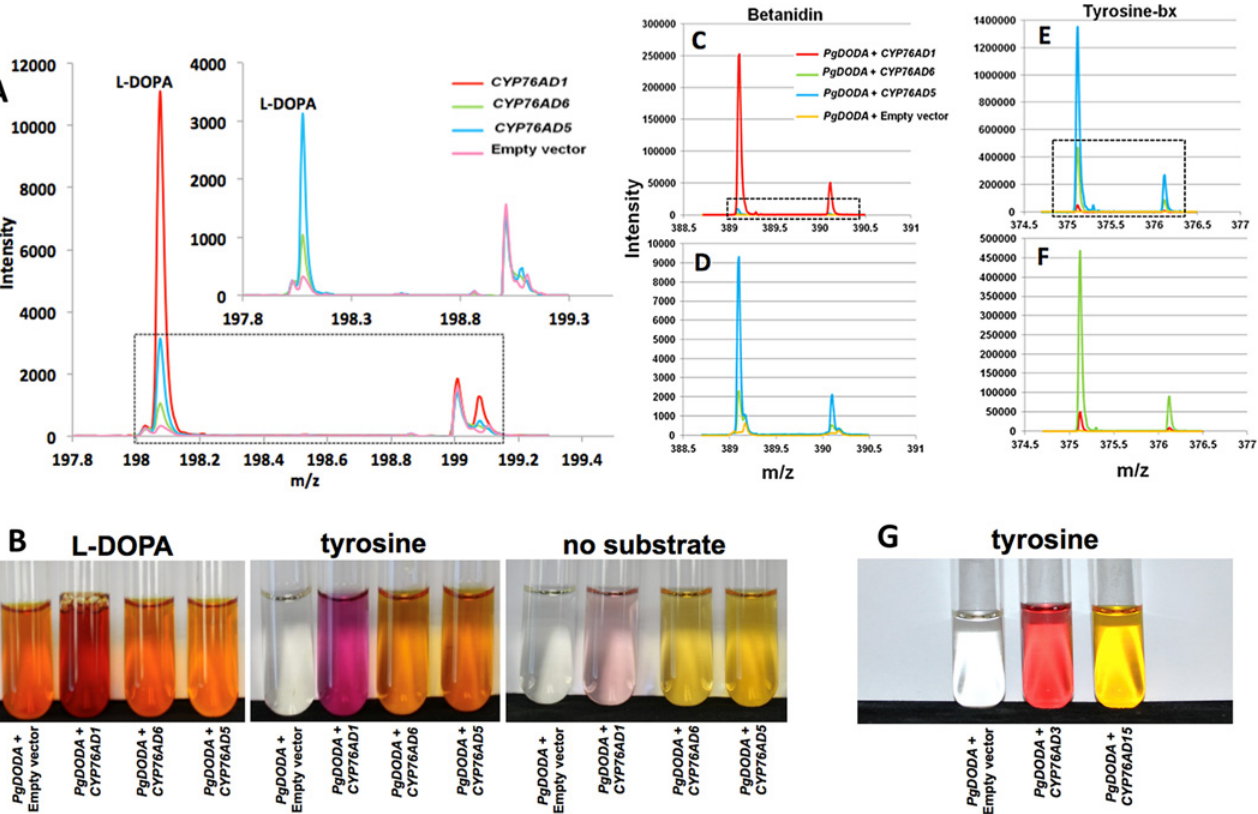
Fig 3. All tested CYP76AD proteins perform tyrosine hydroxylation in yeast. A. HPLC/ms analysis of yeast expressing CYP76AD1, CYP76AD6, and CYP76AD5 individually shows that all will hydroxylate tyrosine to L-DOPA. Inset shows expanded view of lower peaks. Yeast containing empty vector either have weak tyrosine hydroxylation activity or produce a compound that co-migrates with L-DOPA. B to F. Same yeast strains as in A with the addition of PgDODA. B. images of the cultures fed L-DOPA, tyrosine, or no added substrate with the tyrosine-fed panel corresponding to C through F. C and D. HPLC/ MS analysis of the red betanidin pigment with the lower peaks for CYP76AD6, CYP76AD5, and empty vector expanded in D. E. and F. HPLC/MS analysis of the yellow tyrosine-betaxanthin pigment with the lower peaks for CYP76AD6, CYP76AD1, and empty vector expanded in F. Note that CYP76AD1 produces large amounts of betanidin and small amounts of betaxanthin. G. Yeast cultures expressing PgDODA alone and PgDODA with CYP76AD3 or CYP76AD15 from Mirabilis jalapa and fed tyrosine. CYP76AD3 has CYP76AD1-like activity producing red pigment and CYP76AD15 has CYP76AD6/5-like activity producing yellow